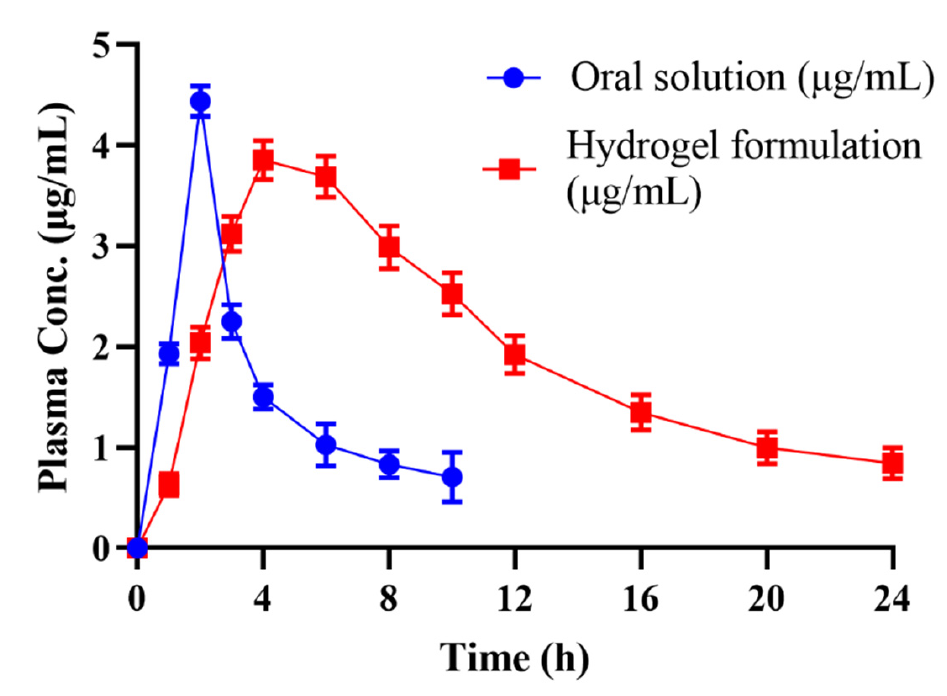
Figure 12. Combined plasma concentration graph of pure cytarabine powder solution and cytarabine-loaded hydrogel formulation after oral administration. Table 5. Pharmacokinetic parameters of pure Cytarabine powder solution and Cytarabine loaded hydrogel after oral